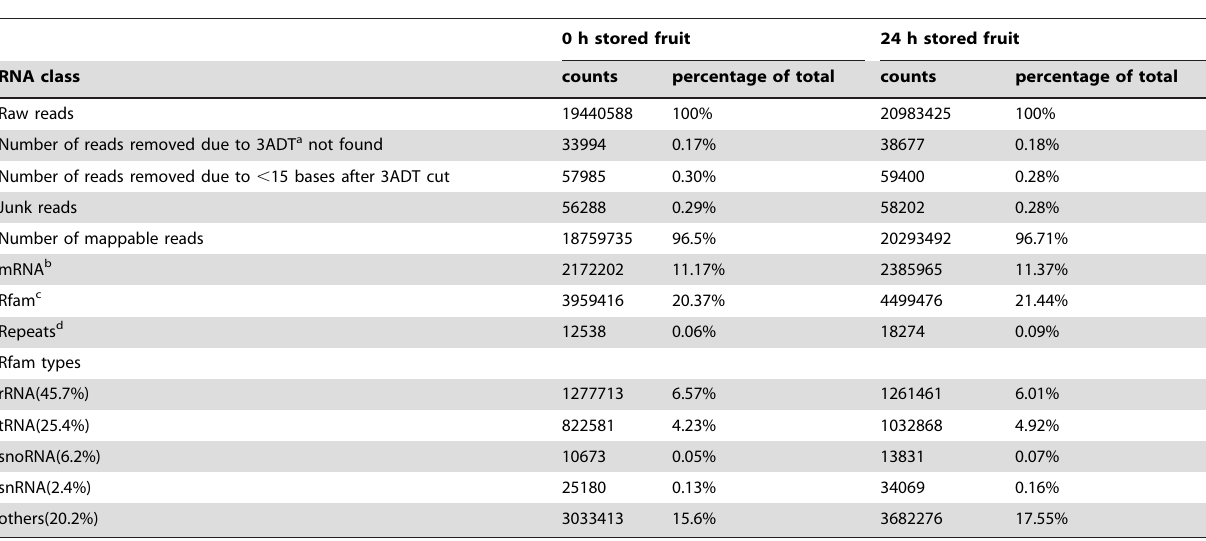
Table 1. Distribution of the small RNA sequences in the two